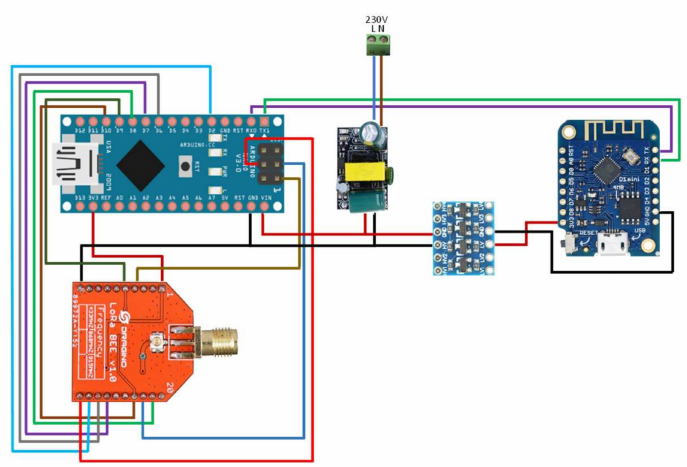
Figure 3. Wiring diagram of the GREMNL.